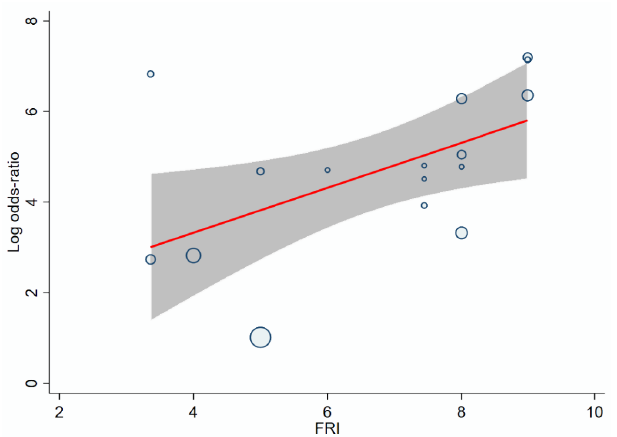
Figure 4. Bubble plots of meta-regression between FRI and ln(OR) of automatic diagnosis by facial recognition. FRI = facial recognition intensity, OR = diagnostic odds ratio. The straight line indicates linear prediction in the meta-regression model between FRI and diagnostic accuracy. The gray zone indicates the 95% confidence region, and the round bubbles represent the eligible studies. The size of the bubbles indicates the impact on the model.